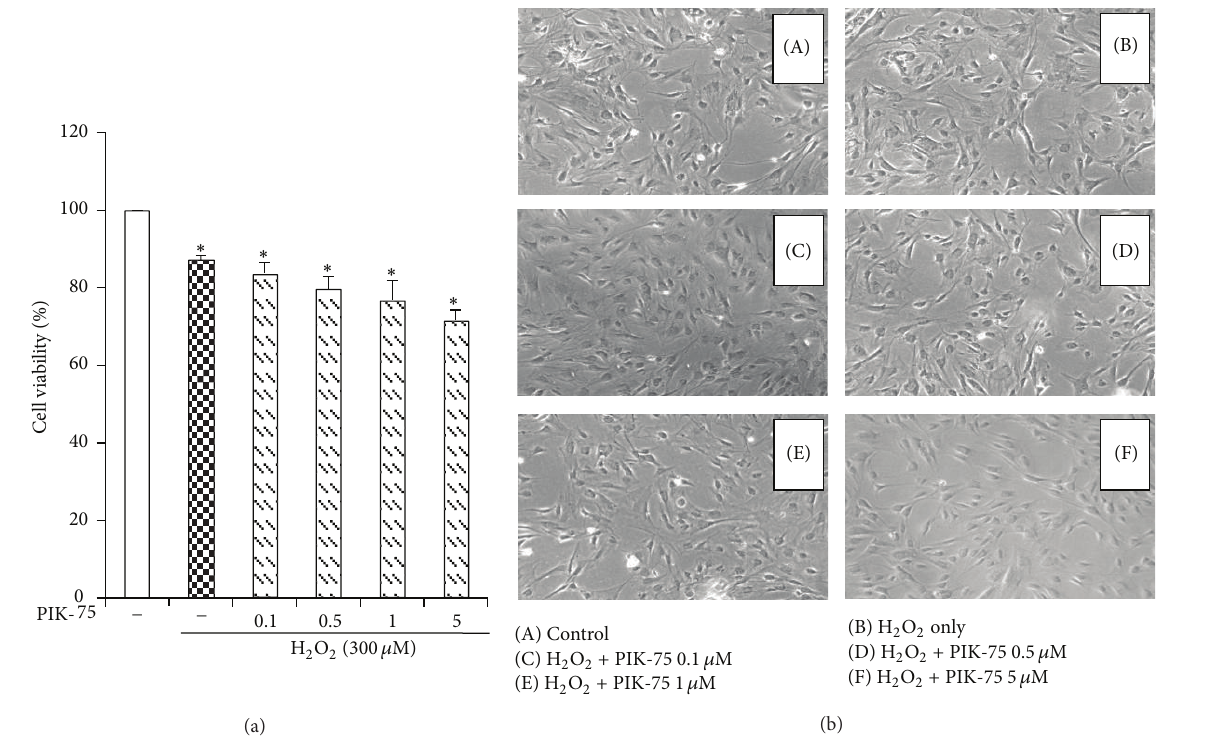
Figure 4: The cell viability and the morphology of H 2 O 2 -treated EECs. Serum-starved EECs were preincubated in the presence of PIK-75 for 1 hour at the indicated concentration. EECs were then stimulated with 300 𝜇 M H 2 O 2 for 6 hours. (a) The cell viability was measured using MTT assay. Data are expressed as means ± S.E of three experiments (Student’s t -test; ∗ 𝑃 < 0.05 versus control). (b) The morphologic changes of EECs were observed. Magnification: